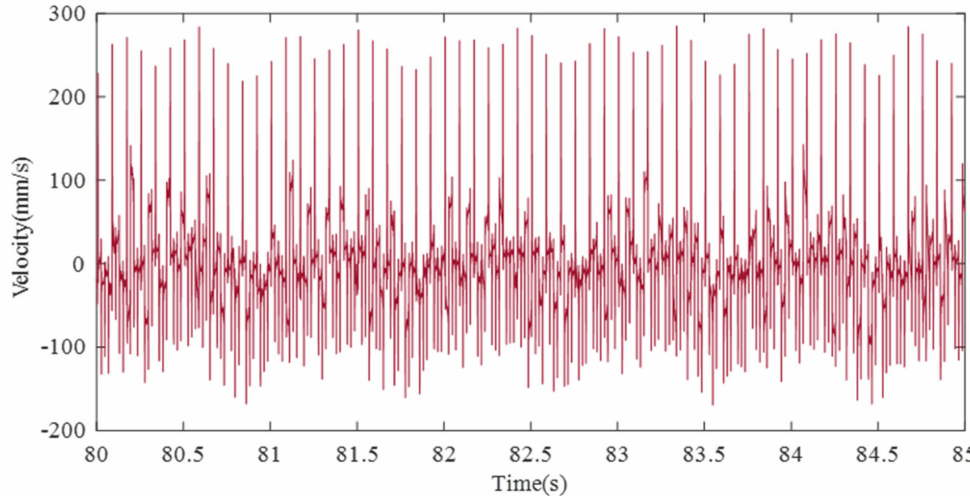
Figure 8. Measured data by the LDV.